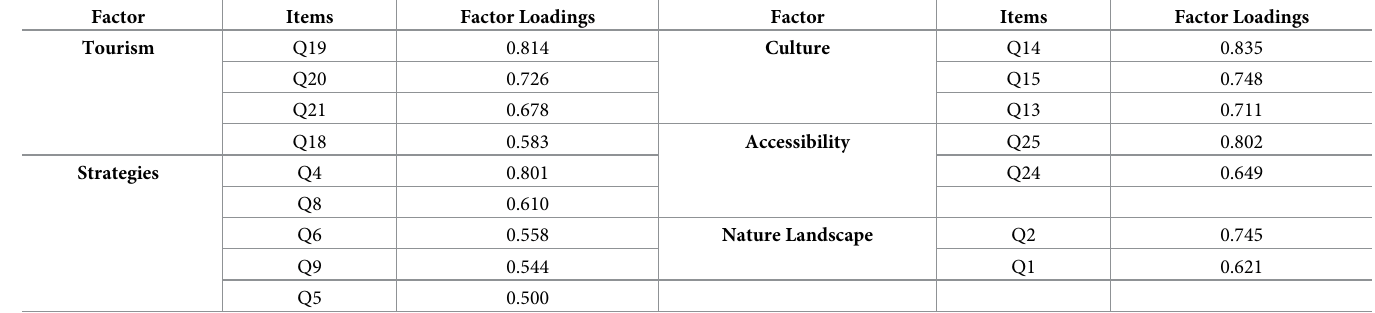
Table 4. Underlying dimensions of landscape value assessment using principal axis factoring extraction method and Promax Rotation with Kaiser Normalization (KMO = 0.855, the significance level of Bartlett’s Test of Sphericity is 0.000, total variance explained is 53.725%). Factor